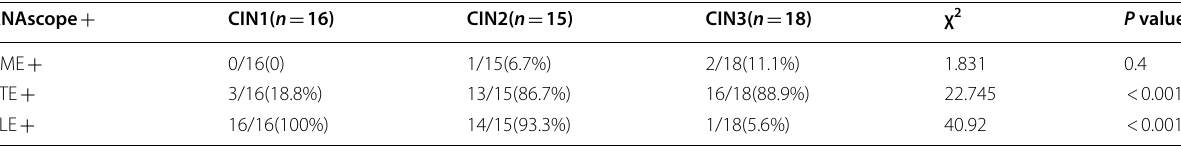
Table 3 Distribution characteristics of HR-HPVRNAscope expression patterns for different CIN lesions in the control group